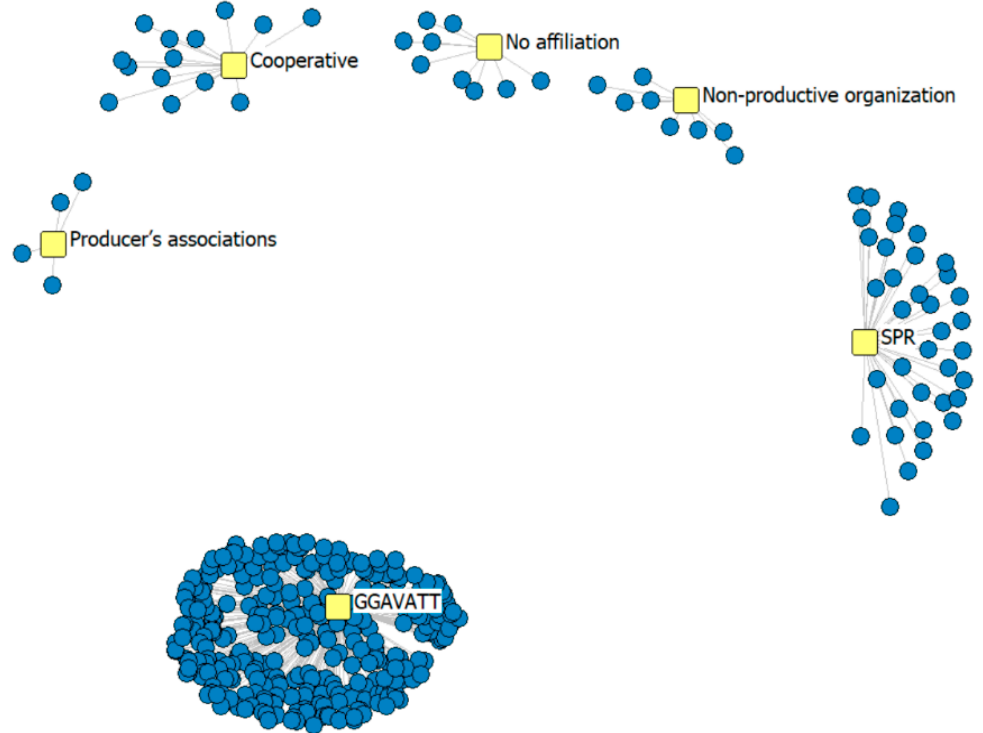
Figure 1. Two-mode network visualization of farmers and type of organization. Organizations: GGAVATT (Live- stock Groups for Technological Validation and Transfer), SPR (The Rural Production Society), Cooperative, Producer’s organization, Non-productive organization, No affiliation), Farmers.